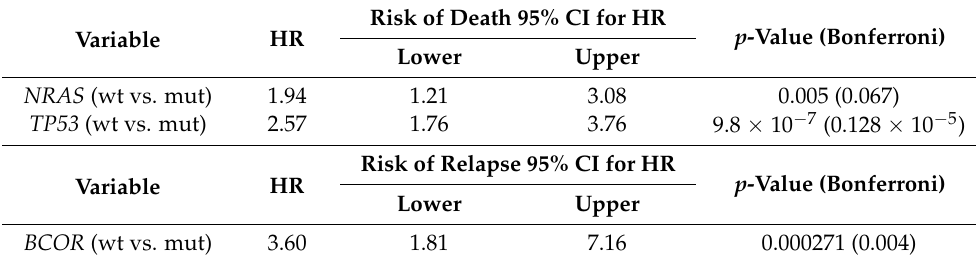
Table 2. Biomarkers consistently associated with death or